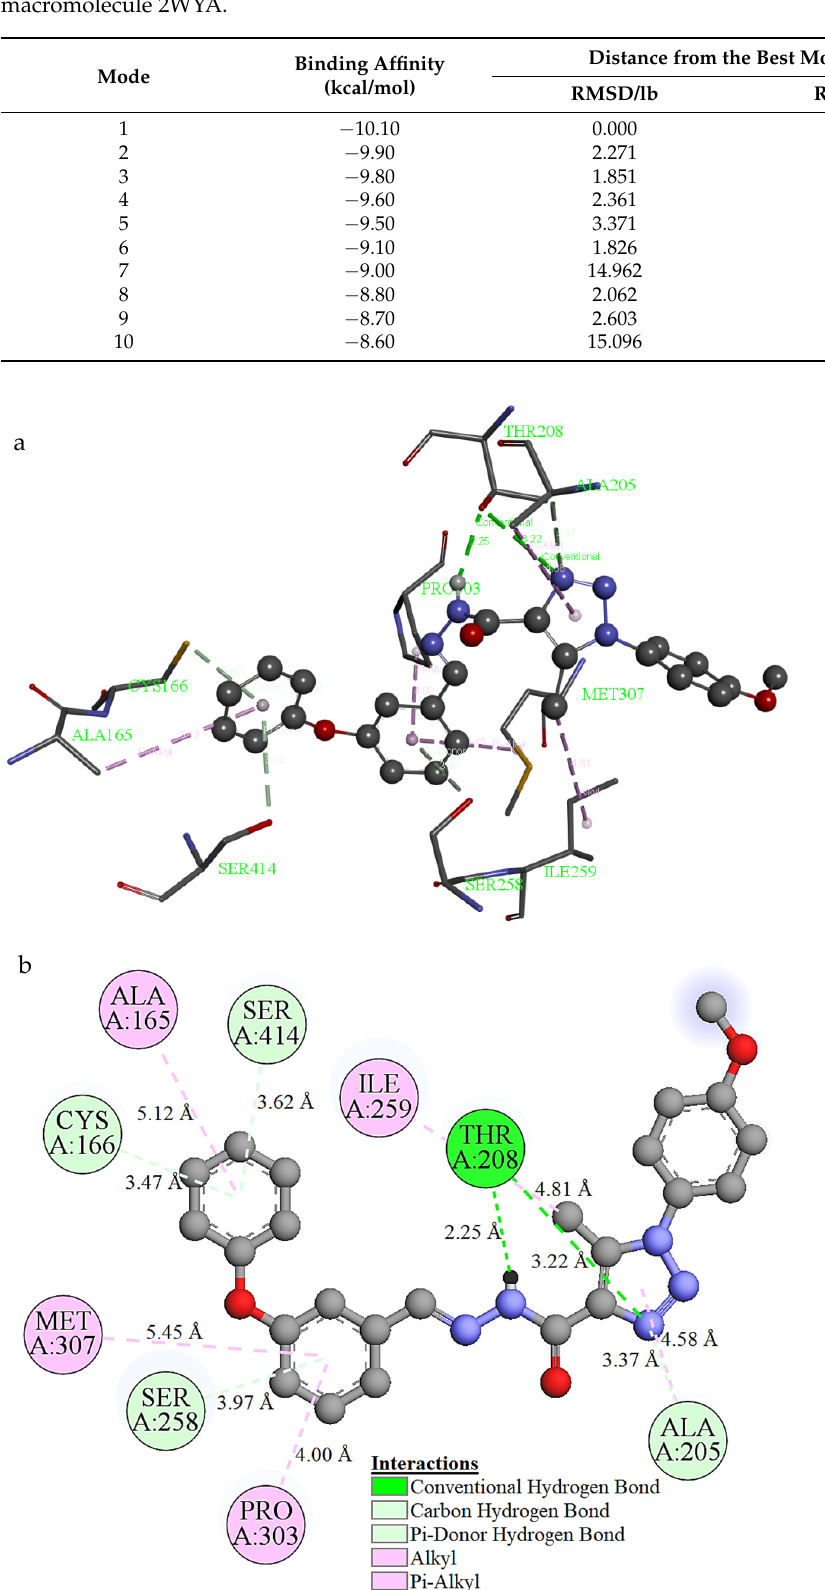
Figure 11. Three-dimensional ( a ) and two-dimensional ( b ) visualizations of intermolecular interac- tions between 2 and the A chain of the target macromolecule 2WYA.